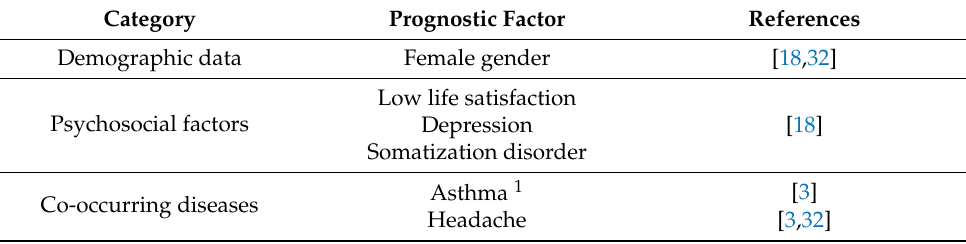
Table 4. Evidence-based prognostic factors for the persistence of non-specific back pain in children and